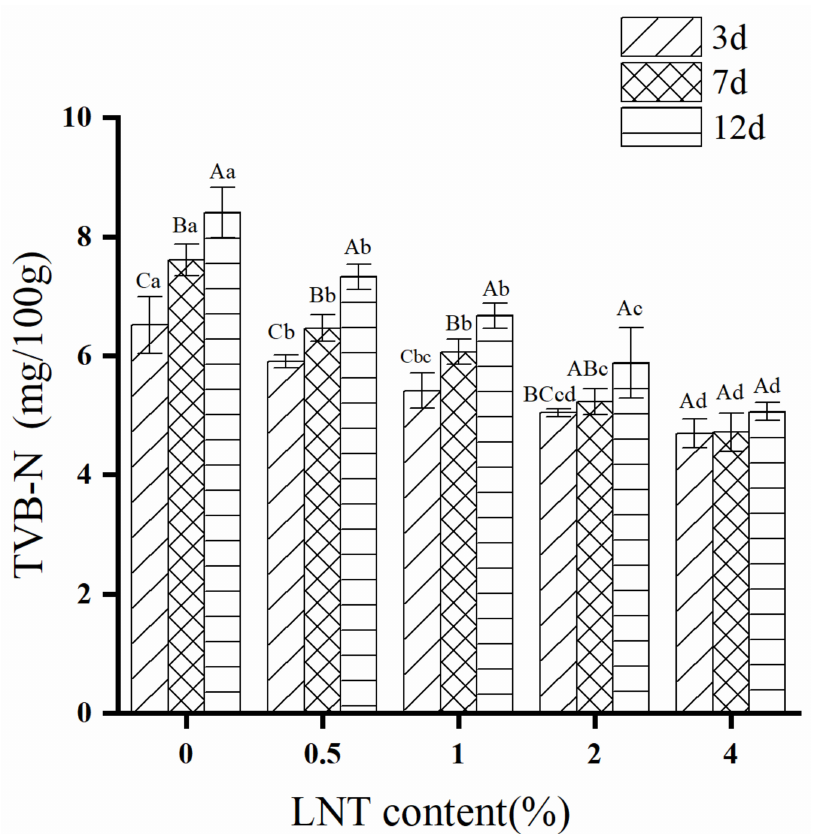
Figure 2. Effects of LNT content and storage time on TVB-N of goose meatballs during cold stor- age (4 ◦ C). Capital letters indicate significant differences between different storage times for the same sample ( p ≤ 0.05). Lowercase letters indicate significant differences between different contents of LNT sample during the same storage time ( p ≤